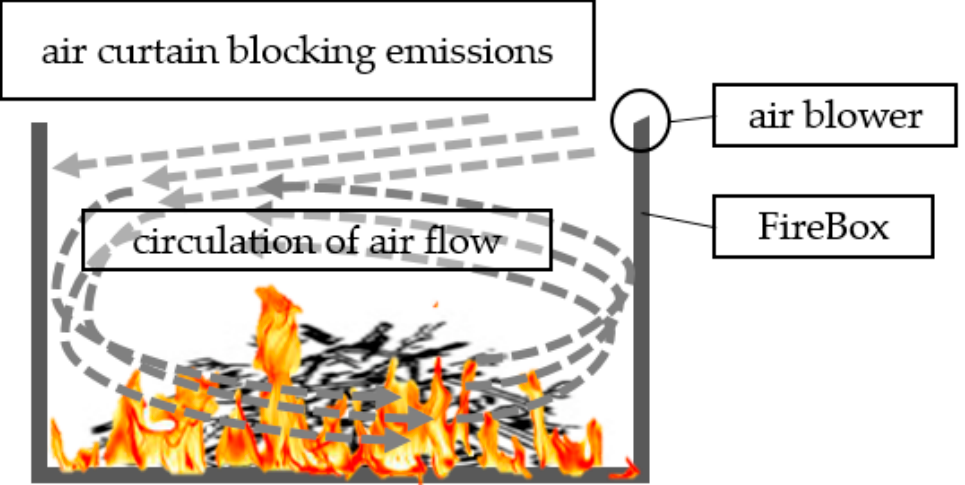
Figure 2. Principle of an Air Curtain Burner: the air curtain blocking emission and circulating the air inside FireBox is created when turning on the air blower.